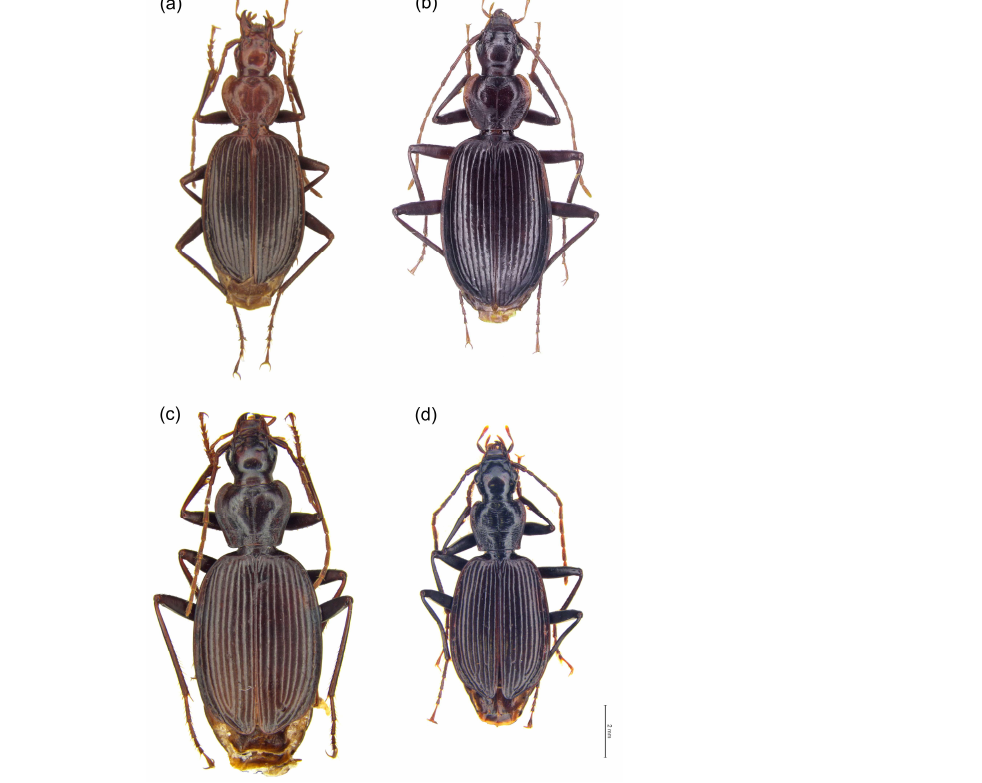
Figure 9. Habitus of Platynus species: ( a ) P. maritimus n. sp .; ( b ) P. occitanus n. sp .; ( c ) P. simonisi n. sp .; ( d ) P. vignai n. sp .